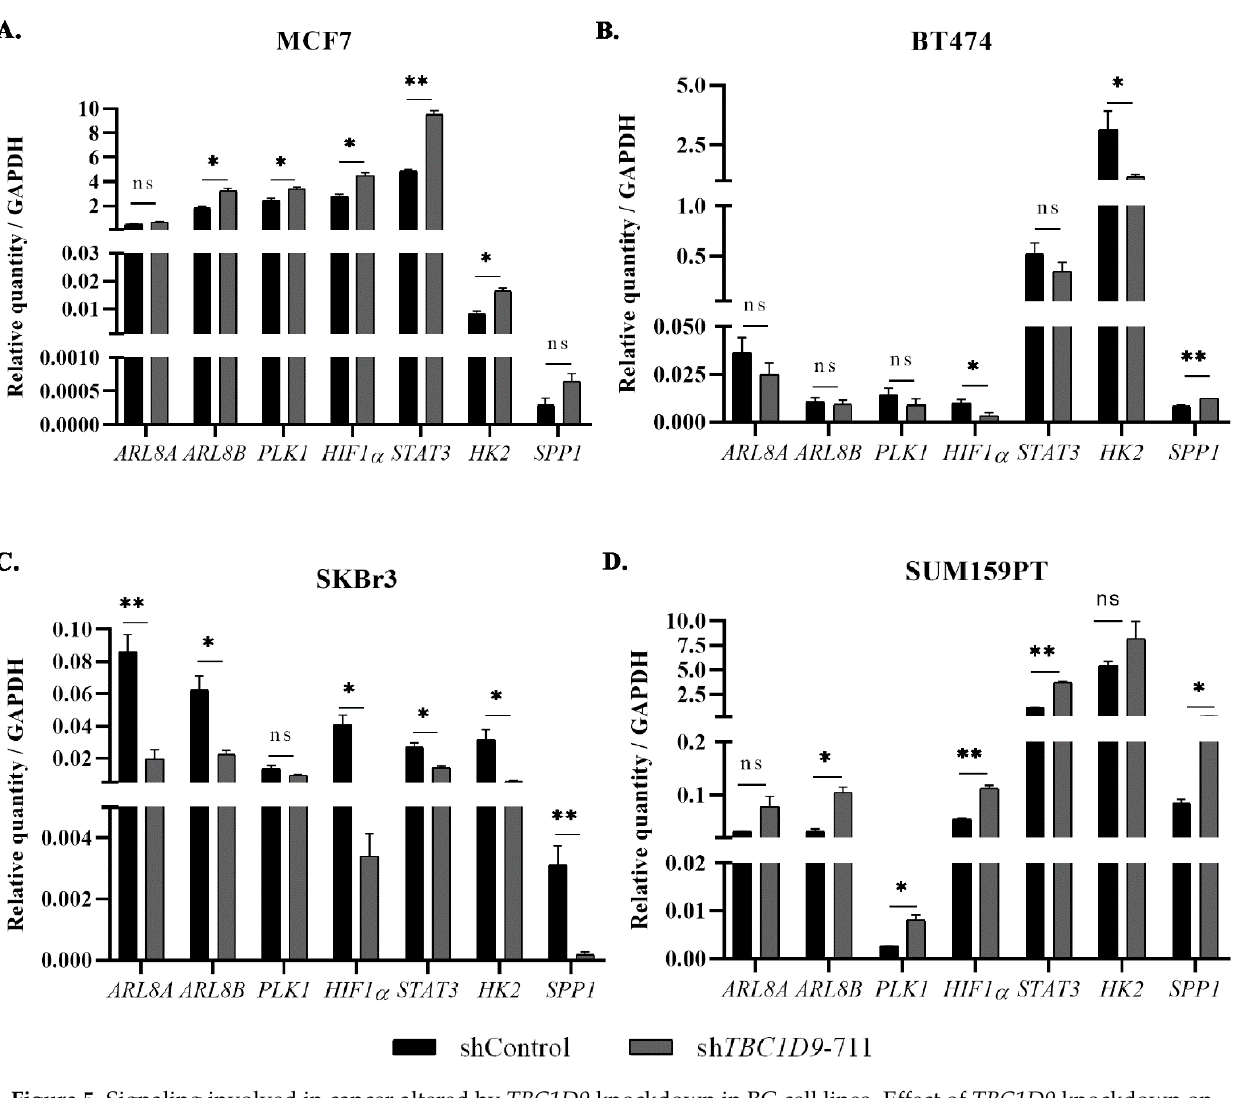
Figure 5. Signaling involved in cancer altered by TBC1D9 knockdown in BC cell lines. Effect of TBC1D9 knockdown on mRNA expression of ARL8A , ARL8B , PLK1 , SPP1 , STAT3 , HK2 , and HIF-1 α in MCF7 (luminal A) ( A ), BT-474 (luminal B) ( B ), SKBr3 (HER2) ( C ), and SUM159PT (TNBC) ( D ). HK = GAPDH ; * p = 0.05, ** p = 0.005; ns: not significant.